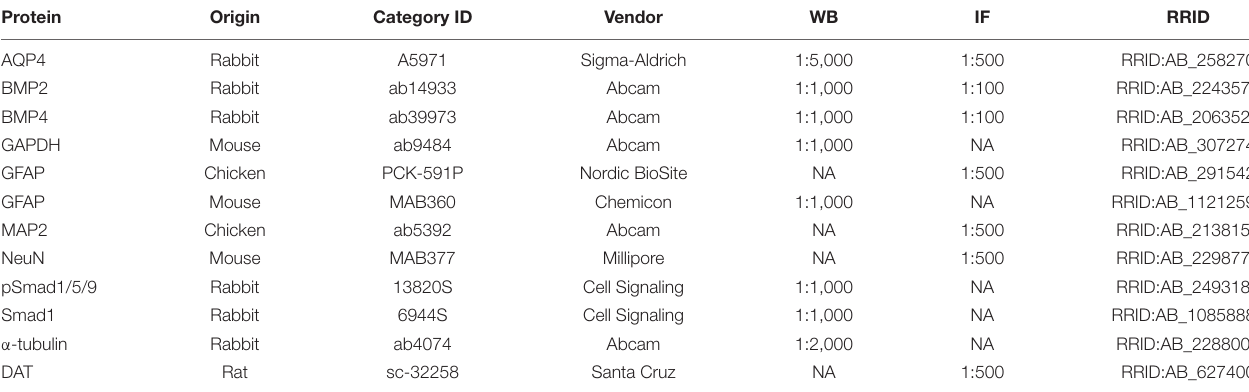
TABLE 1 | Antibodies used for immunostaining.